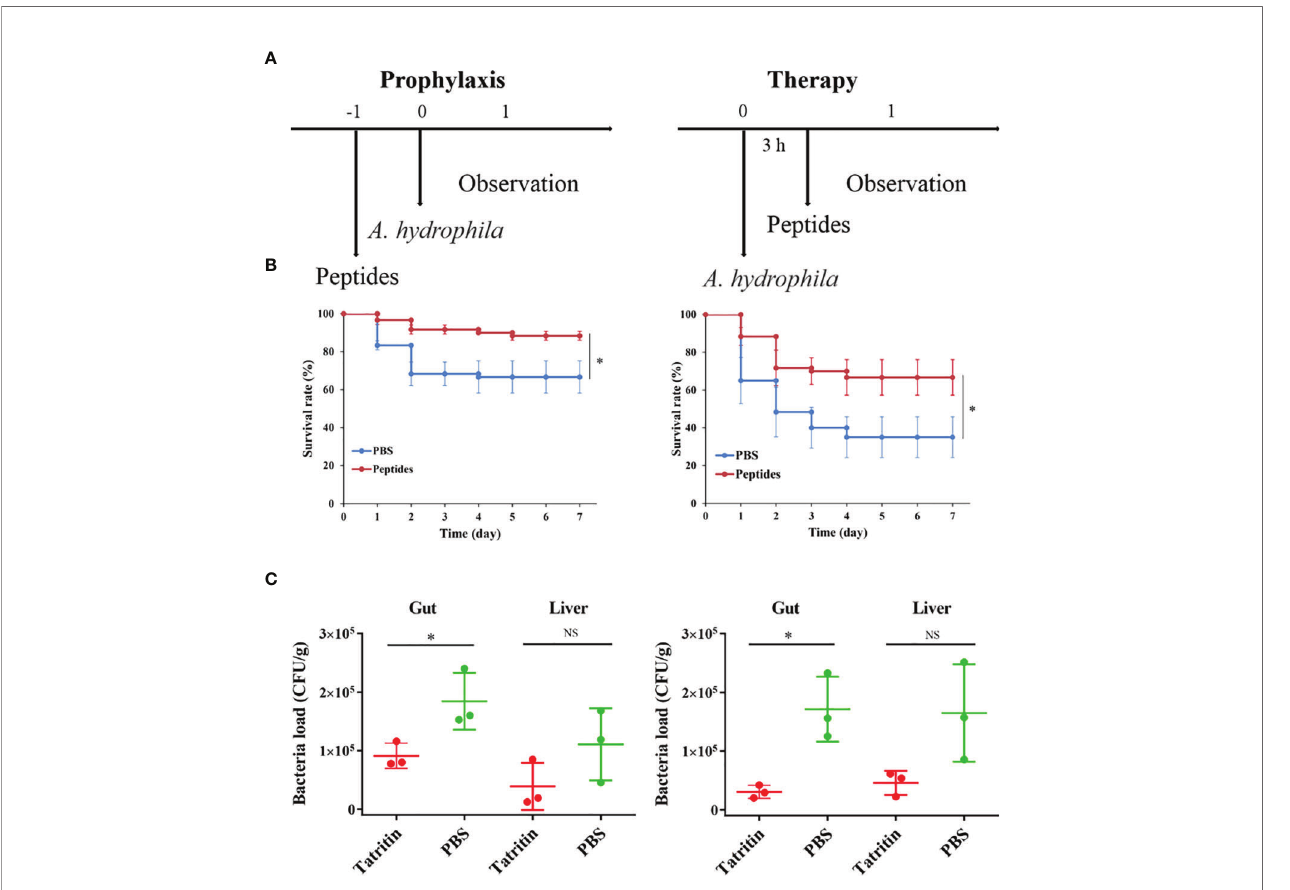
FIGURE 7 | Protective ef fi cacy of Tatritin in the zebra fi sh model of infection. (A) Schematic of the A . hydrophila -infected prophylactic and therapeutic model. (B) Preventive ef fi cacy of Tatritin in the A. hydrophila -infected prophylactic and therapeutic model. Zebra fi sh were received intraperitoneal injection at a single dose of 2 µg/g Tatritin or equal volumes of PBS (n = 20) at 24 h before or 3 h after the pathogenic bacteria of A. hydrophila was injected with a lethal dose of 5.6 × 10 4 CFU. The mortality in each group was recorded for at least 7 days. Experiments were conducted in triplicates, and the data shown are the means. Asterisk indicates that the difference is signi fi cant. (C) At 3 days postinfection, bacterial loads in gut and liver of zebra fi sh infected with A. hydrophila in prophylaxis and therapy groups were detected, (n = 3). * P <0.05, NS, not signi fi